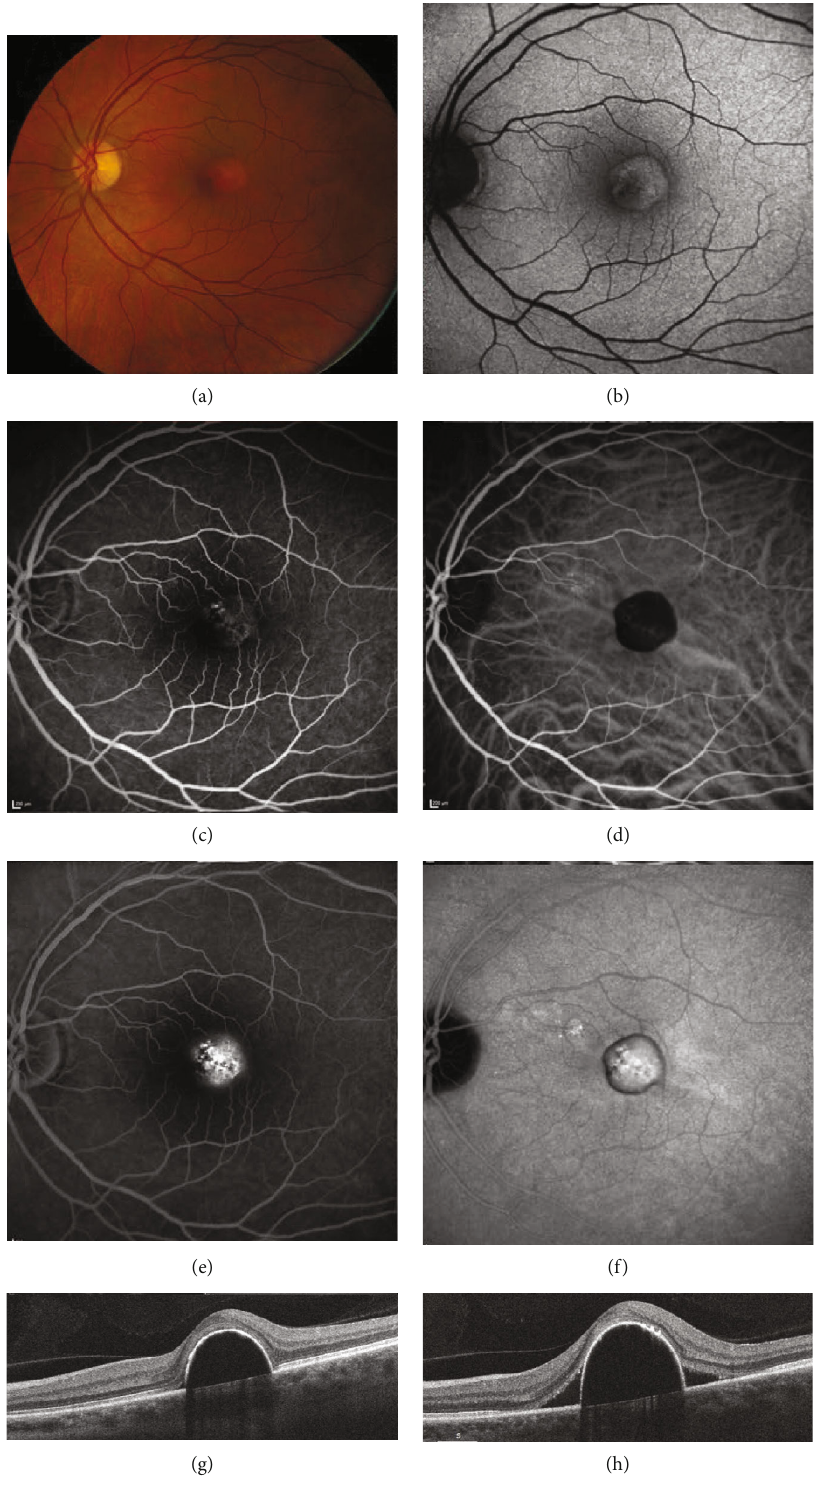
Figure 7: Central serous chorioretinopathy of the left eye. A 56-year-old male was observed for 3 years with worsening of metamorphopsia. (a) Fundus photography showed pigment irregularities and clumping over a pigment epithelial detachment (PED). (b) Fundus auto fl uorescence showed hypoauto fl uorescent changes surrounding the PED with granular hyperauto fl uorescence centrally. (c) Early- phase fl uorescein angiography (FA) revealed faint pinpoint leakage and staining of the PED. (d) Early-phase indocyanine green angiography (ICGA) showed blockage due to the PED. (e, f) Late-phase FA and ICGA showed macular leakage. (g) Optical coherence tomography (OCT) showed a PED but no subretinal fl uid. (h) One year later, OCT showed worsening of the PED and new subretinal fl